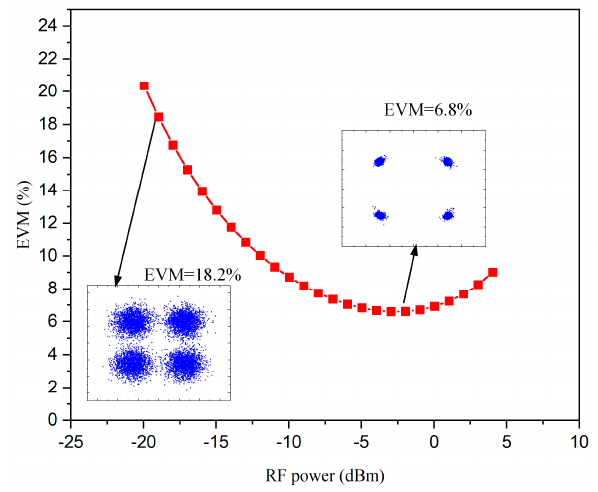
Figure 8. Measured EVM and constellation diagram.